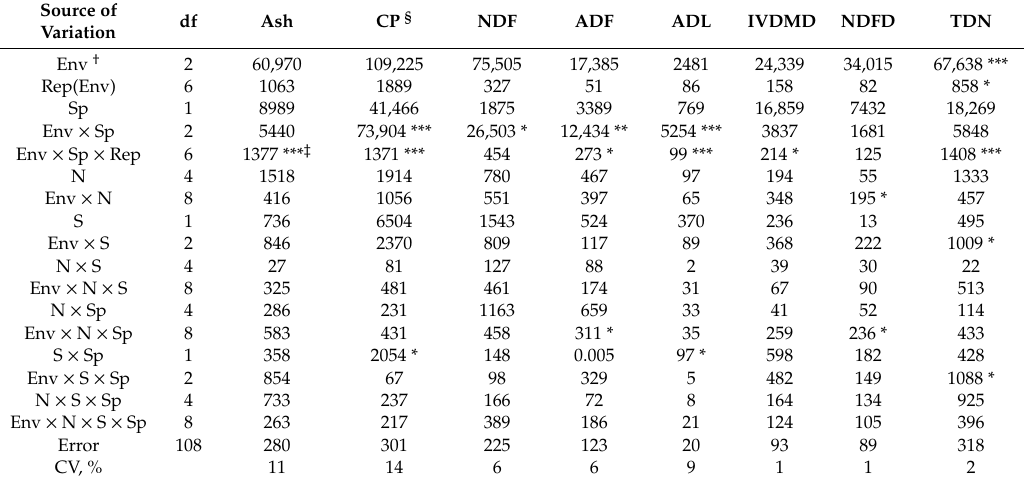
Table 7. Analysis of variance and mean squares of forage quality components of brassica leaves for nitrogen (N) and (S)rates and species in Prosper 2012 and 2014, and in Walcott, ND, USA in 2014. Source of df Ash Variation